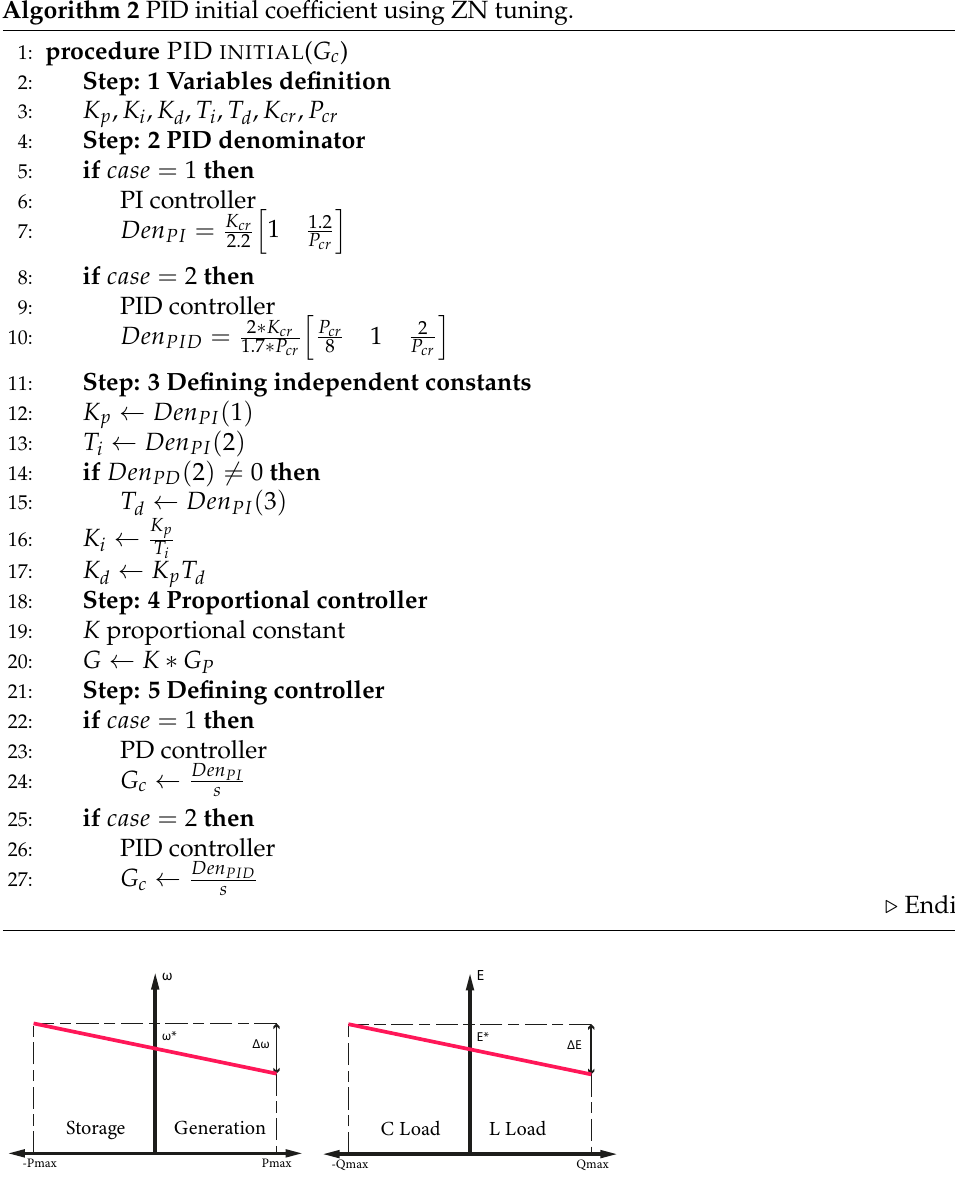
Figure 4. Droop control controlling active and reactive